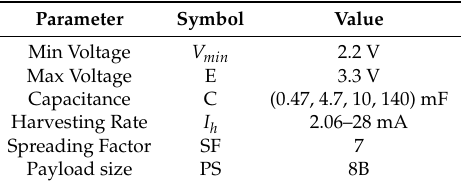
Table 2. Experimental